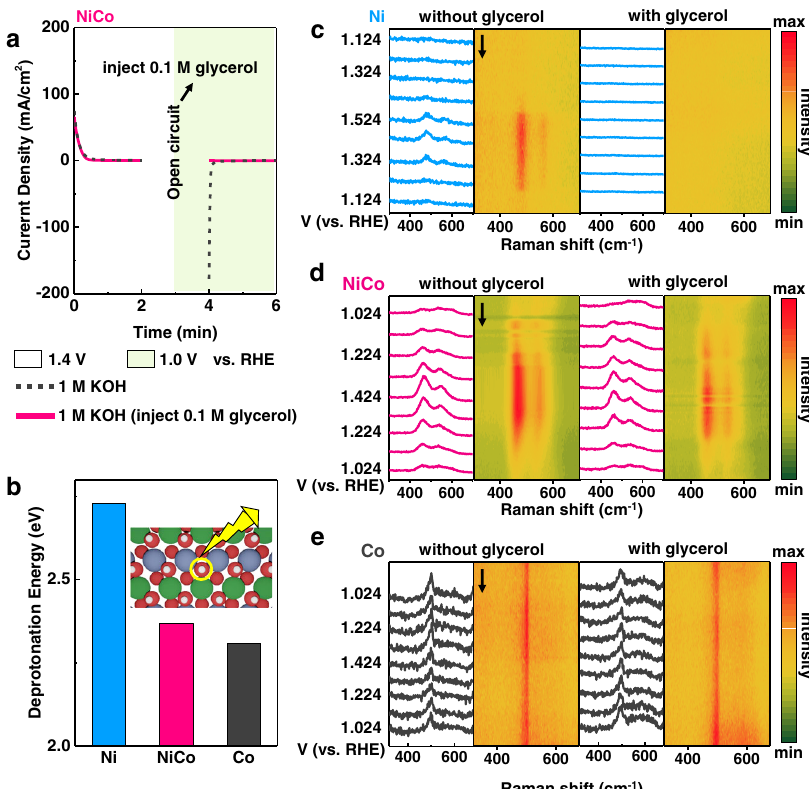
Fig. 3 The impact of proton deintercalation process on the dehydrogenation step during GOR. a Muti-potential step curves of NiCo hydroxide. b Deprotonation energy, i.e, energy required for the deintercalation of one proton from the lattice, of Ni, NiCo, and Co hydroxide. The green, blue, red, and white balls represent the Ni, Co, O, and H atoms, respectively. In-situ Raman spectroscopies for c Ni hydroxide, d NiCo hydroxide, and e Co hydroxide in 1 M KOH without (left) and with (right) 0.1 M